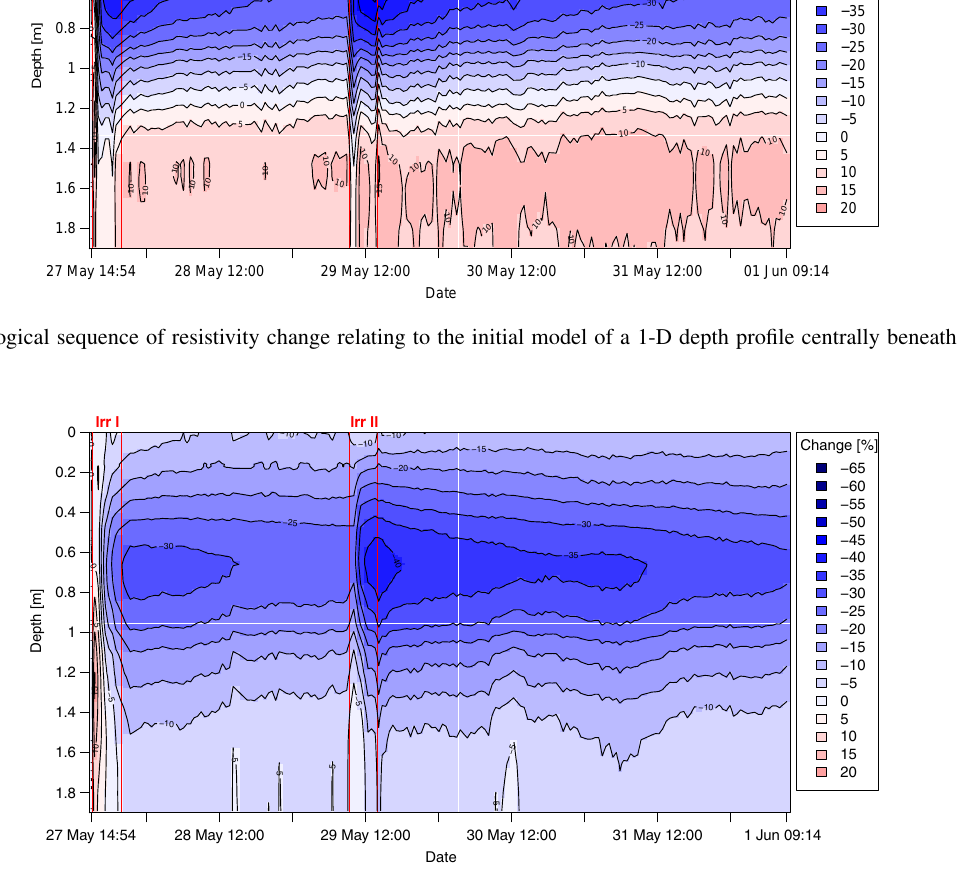
Figure 9. Chronological sequence of resistivity change relating to the initial model of a 1-D depth profile 1.5m downslope of the irrigation